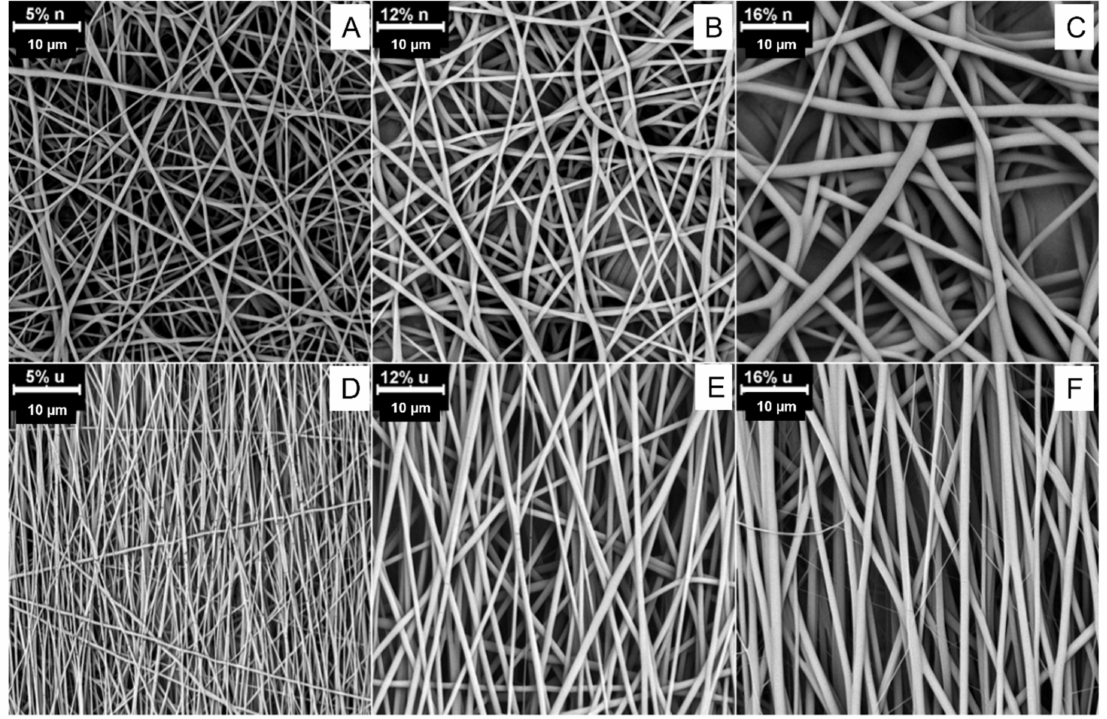
Figure 2. The morphology of obtained fibrous mats with a random arrangement of the fibers: ( A ) rPU5, ( B ) rPU12, and ( C ) rPU16 and aligned fibers ( D ) aPU5, ( E ) aPU12 and ( F ) aPU16. Table 1. The average diameter of obtained fibers. Average Diameter for Average Diameter for Concentration [%] Random Fibers [nm] Aligned Fibers [nm] 5 410 ± 90 360 ± 70 12 1160 ± 260 890 ± 130 16 1760 ± 540 1200 ±